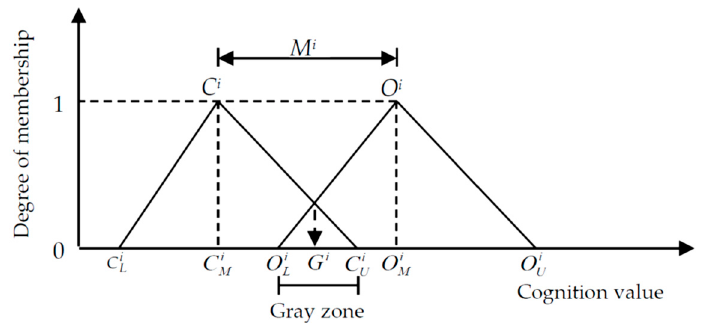
Figure 2. Two triangular fuzzy numbers [76].